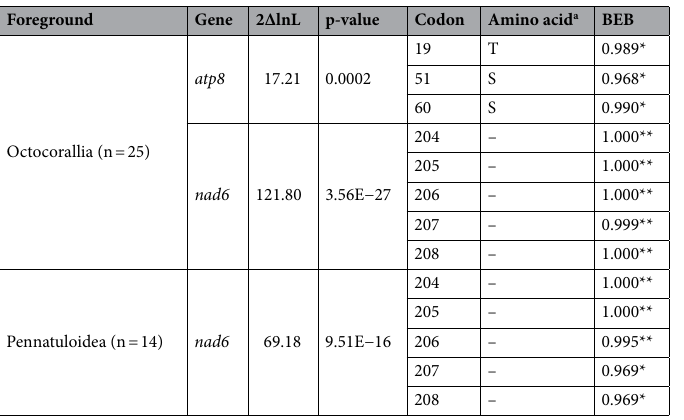
Table 1. Sites under positive selection as determined by BEB analysis within the site models (M1a vs. M2a). Amino acid refers to IUPAC amino acid codes. *BEB > 95%, **> 99%. a Amino acids listed are in reference to the first sequence in alignment; “–” denotes a gap at that